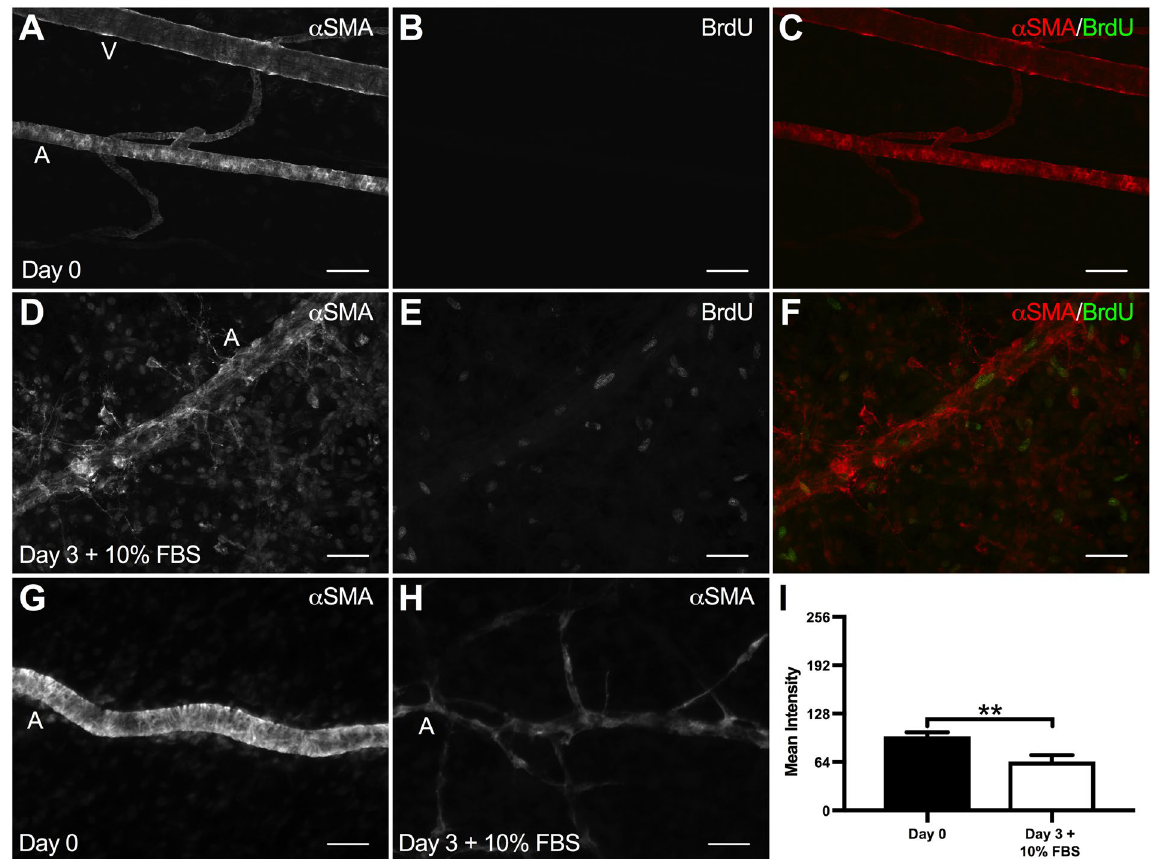
Figure 5. Evaluation of smooth muscle cell phenotype in the rat mesentery culture model. ( A–F ) Comparison of Day 0 and Day 3 + 10% FBS SMC proliferation. BrdU and α SMA labeling identified increased vascular cell proliferation after three days in culture with 10% FBS compared to Day 0 tissues. Scale bars = 50 μ m. A = arteriole, V = venule. ( G–I ) Evaluation of α SMA labeling intensity. ( G , H ) Representative α SMA labeling for Day 0 and Day 3 + 10% FBS tissues. Scale bars = 50 μ m. A = arteriole. ( I ) Comparison of Day 0 and Day 3 + 10% FBS tissues reveals a decrease in α SMA labeling intensity after three days in culture with serum. Black and white bars represent Day 0 and Day 3 + 10% FBS groups respectively. ** indicates a significant difference of p < 0.01 by two-tailed Student’s